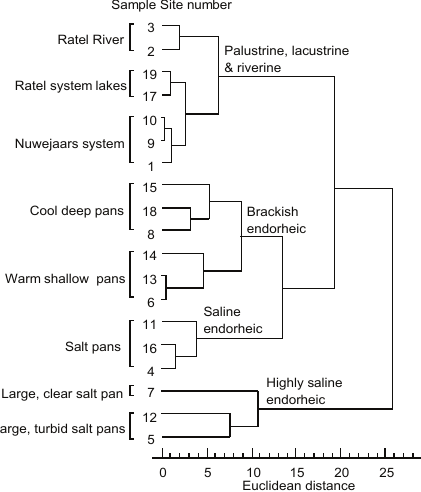
Fig. 3. Classification of wetland systems within Agul- has National Park based physico-chemical variables (water temperature, salinity, pH, dissolved oxygen, tur- bidity) as determined during fish surveys undertaken in during December 2003 and March